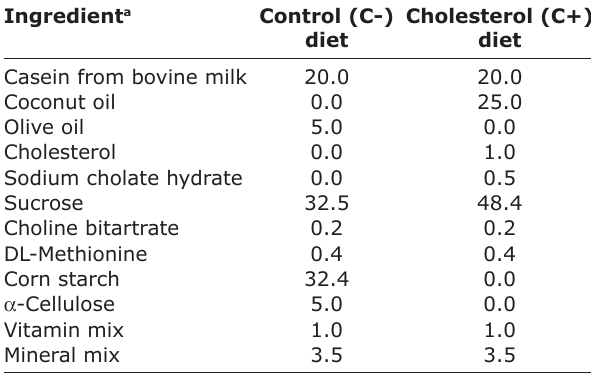
Table-1: Diet composition (%, by weight). Ingredient